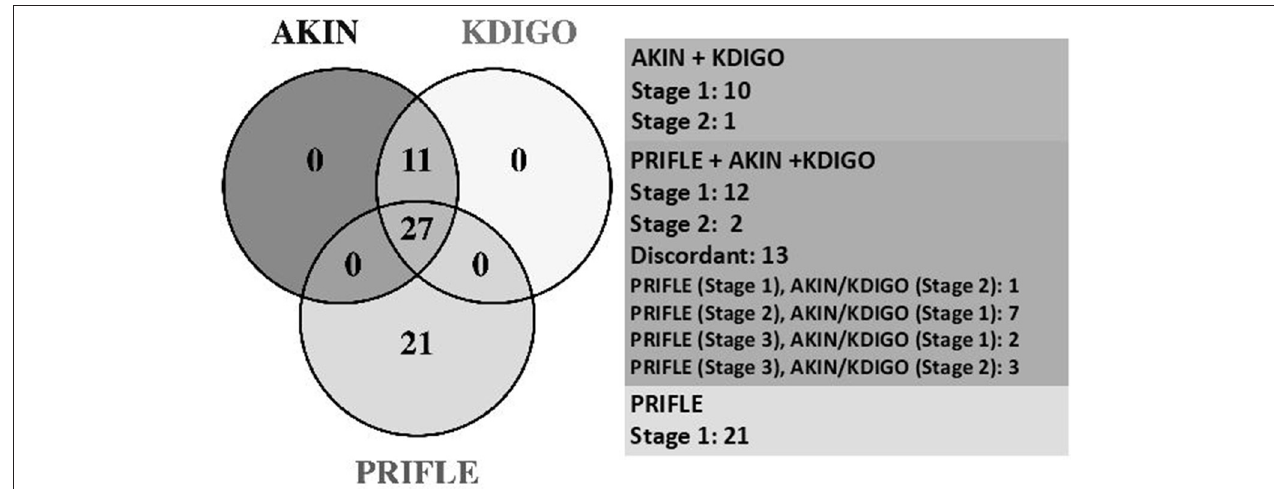
FIGURE 2 | Comparative stages of AKI. AKIN, Acute Kidney Injury Network; KDIGO, Kidney Disease Improving Global Outcomes; PRIFLE, Pediatric Risk, Injury, Failure, Loss, End Stage Renal